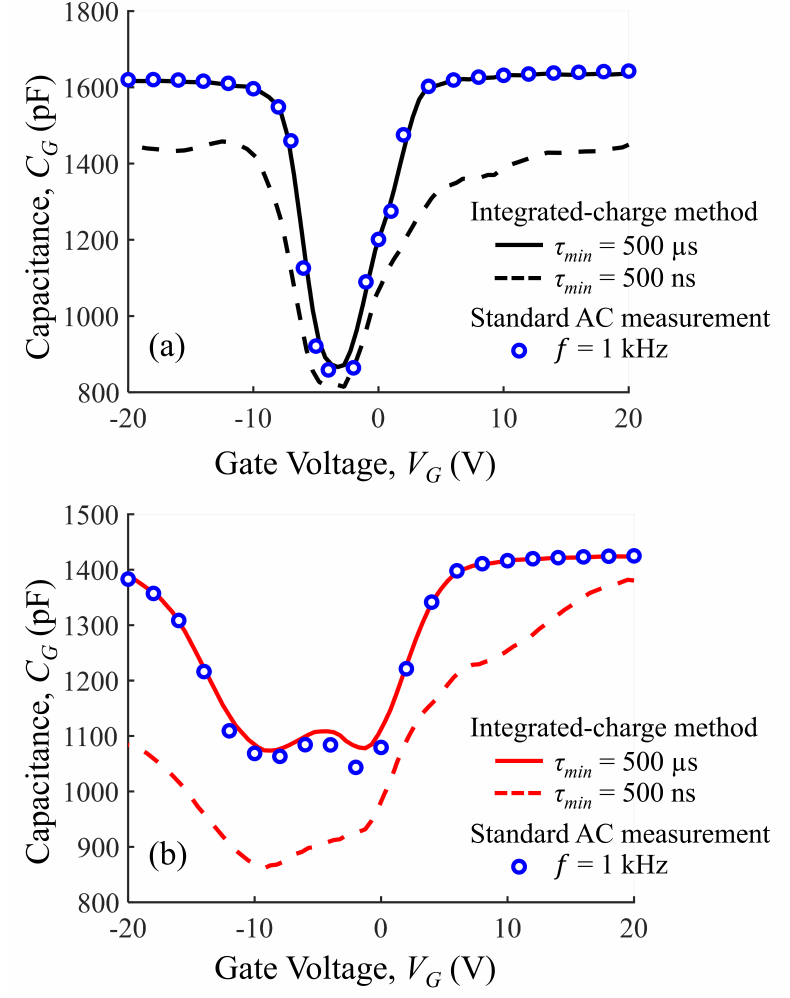
Figure 2. Capacitance–voltage curves for the MOSFETs from manufacturer D with ( a ) planar gate structure; ( b ) trench gate